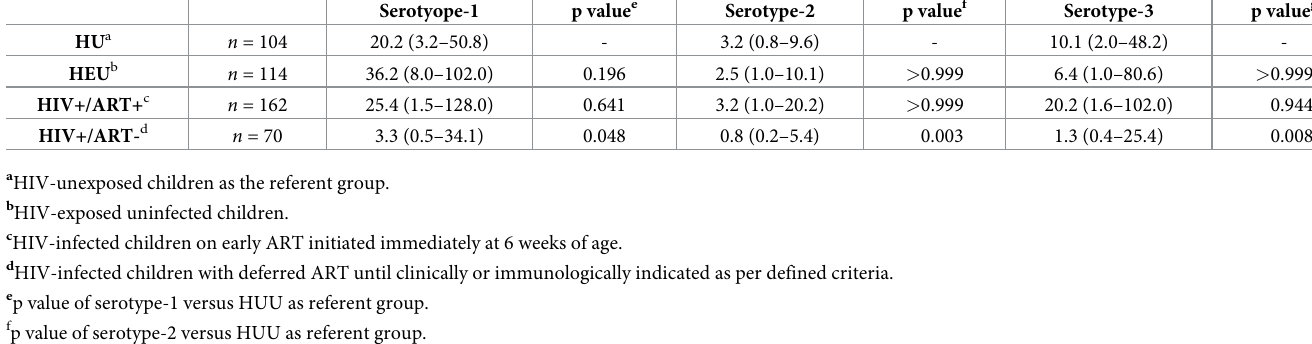
4.7%, p = 0.454) and serotype-3 (301.% vs 24.3%, p = 0.334); Table 3. At 18 weeks of age, GMTs ( � 7.9 for all serotypes) and the percentage of children with sero-protective titres ( � 95.1% for all serotypes) were similar in HIV+/ART+ infants compared to HU children; Table 2 and S1 Fig. Seroconversion rates at 18 weeks of age in HIV+/ART+ infants were higher than HU infants for serotype-1 (21.6% vs 7.7%, p = 0.003) and serotype-3 (21.1% vs 8.7%, p = 0.010), but comparable for serotype 2 (4.9% vs 1.9%, p = 0.324); Table 3. There was no sig- nificant difference in the median fold change in antibody titre at 18 weeks versus 6 weeks of age between HIV+/ART+ and HU infants for serotype-1 (25.4 vs 20.2, p = 0.641), serotype-2 (3.2 vs 3.2, p > 0.999) and serotype-3 (20.2 vs 10.1, p = 0.944); Table 4.